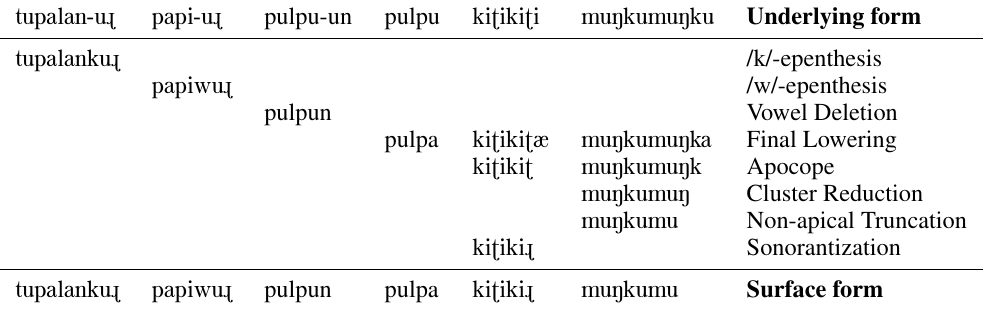
Table 1: Interaction of multiple phonological processes in Lardil